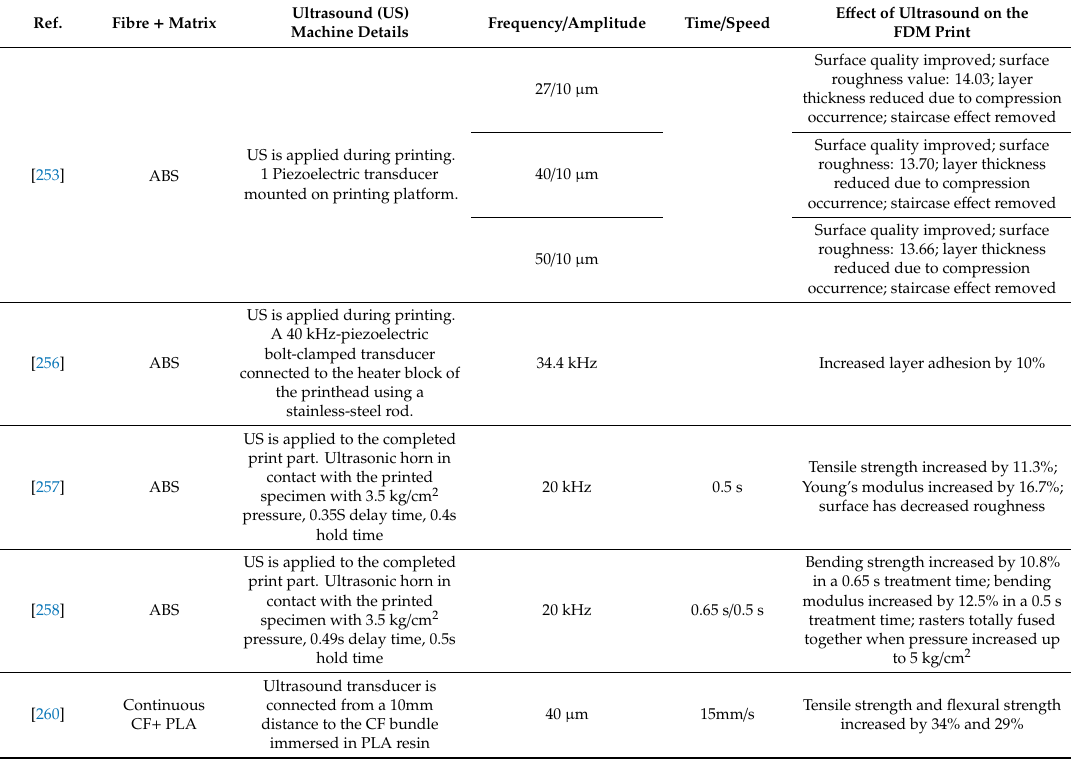
Table 4. Details of ultrasound treatment on the FDM print